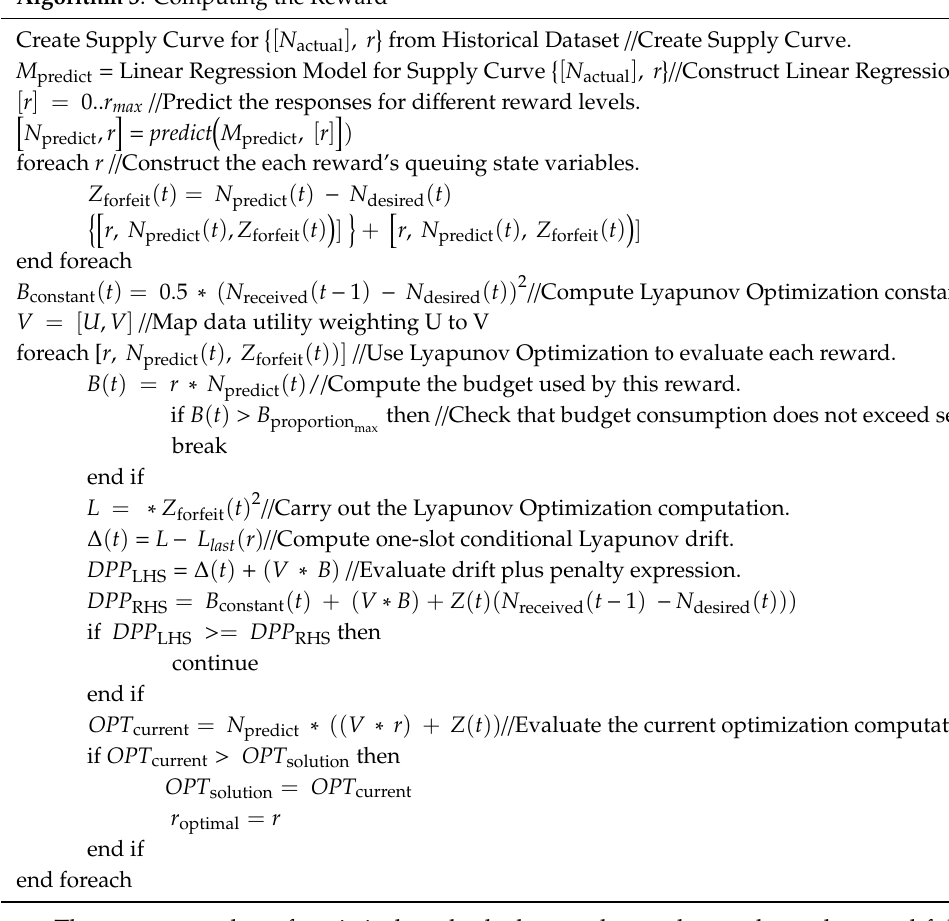
Algorithm 3 : Computing the